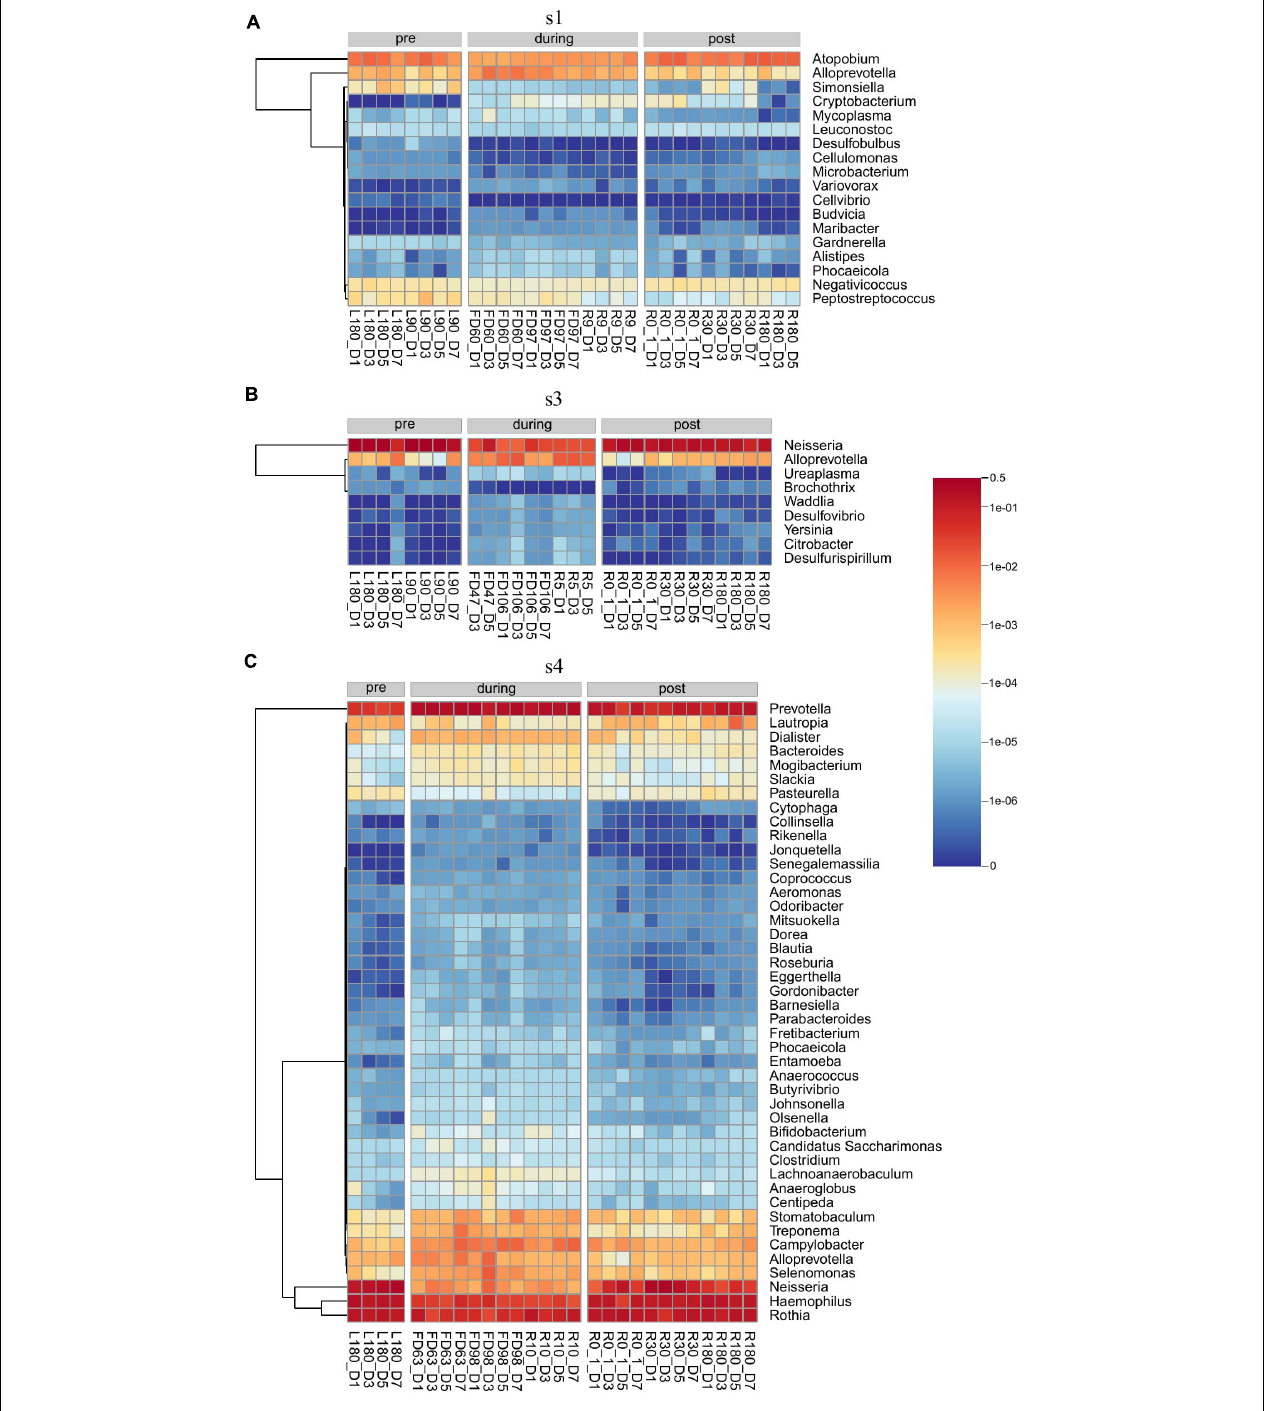
FIGURE 5 | Heatmaps showing the relative abundance of genera identified as differentially abundant in Astronaut 1 (A) , Astronaut 3 (B) , and Astronaut 4 (C) .